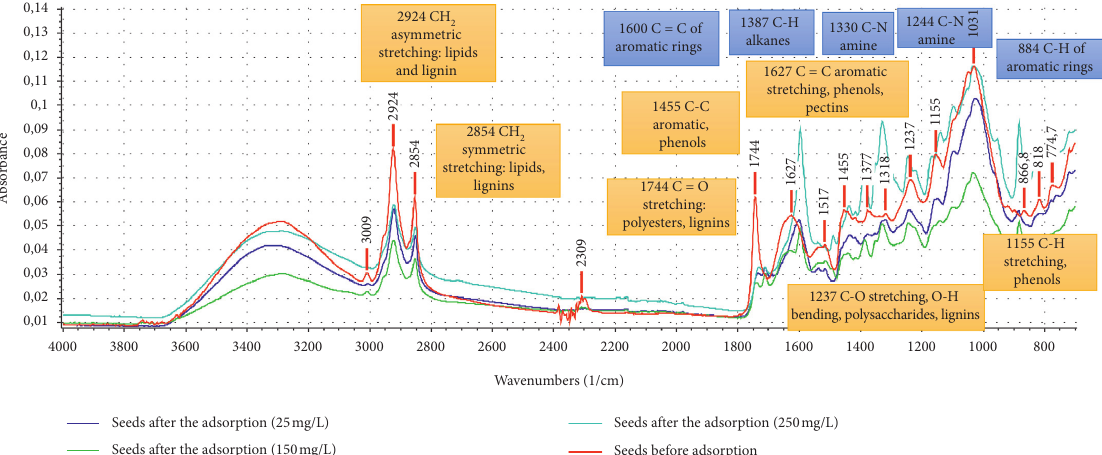
Figure 9: FTIR spectrum of nance seeds before and after MB adsorption (pH 10). Blue tags correspond to functional groups of MB. Orange tags correspond to functional groups of the